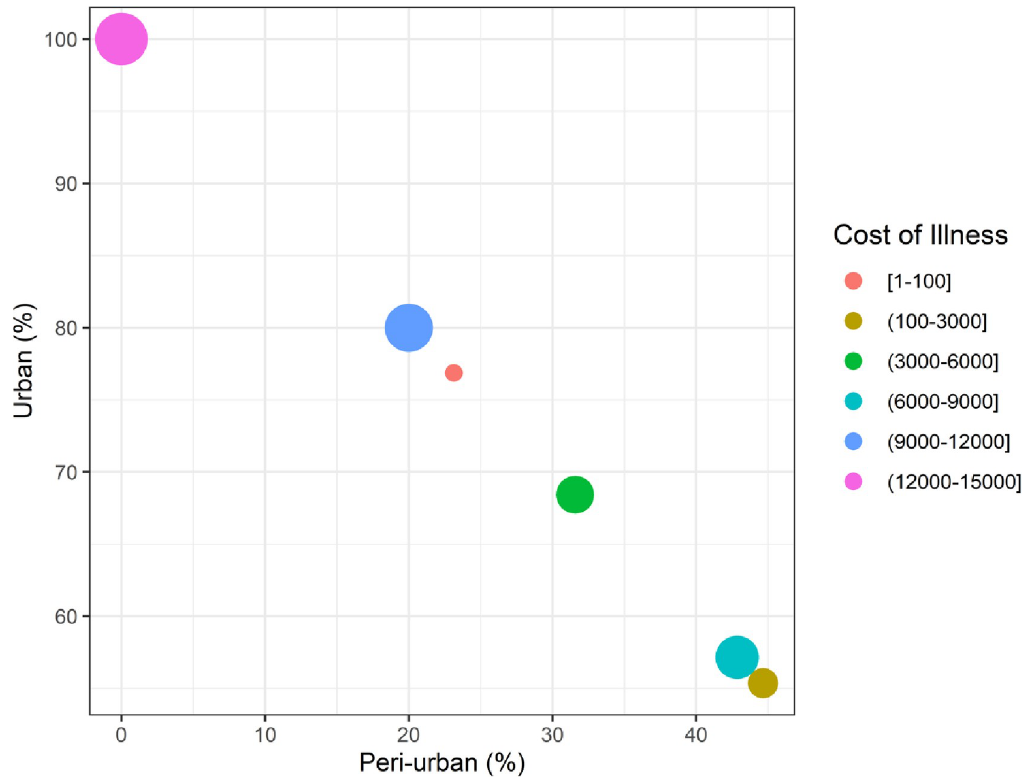
Fig 3. Distribution of cost of illness and willingness to pay of households among urban and peri-urban communities.